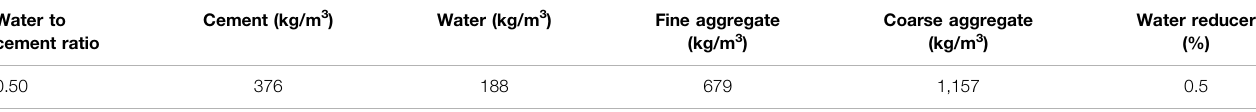
TABLE 1 | Mix design of the nano-modi fi ed concrete. Water to cement